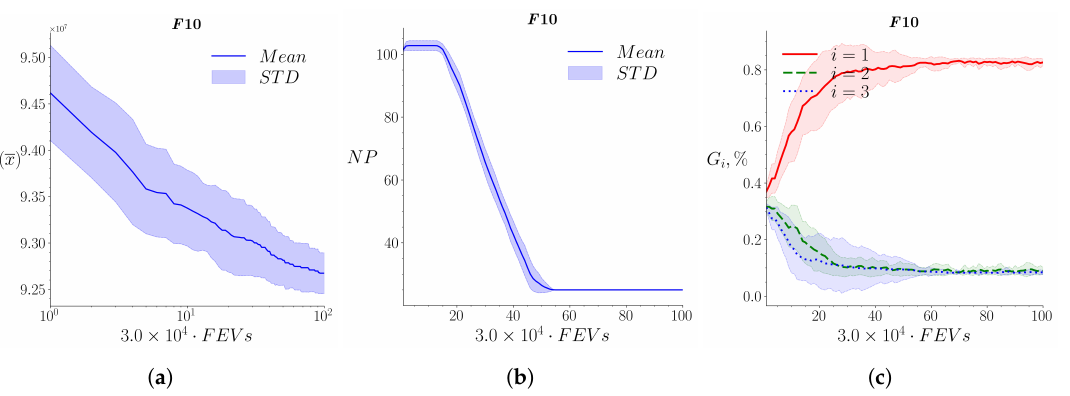
Figure A9. The dynamics of COSACC-LS1 on the F9 problem: ( a ) Convergence; ( b ) Population size;